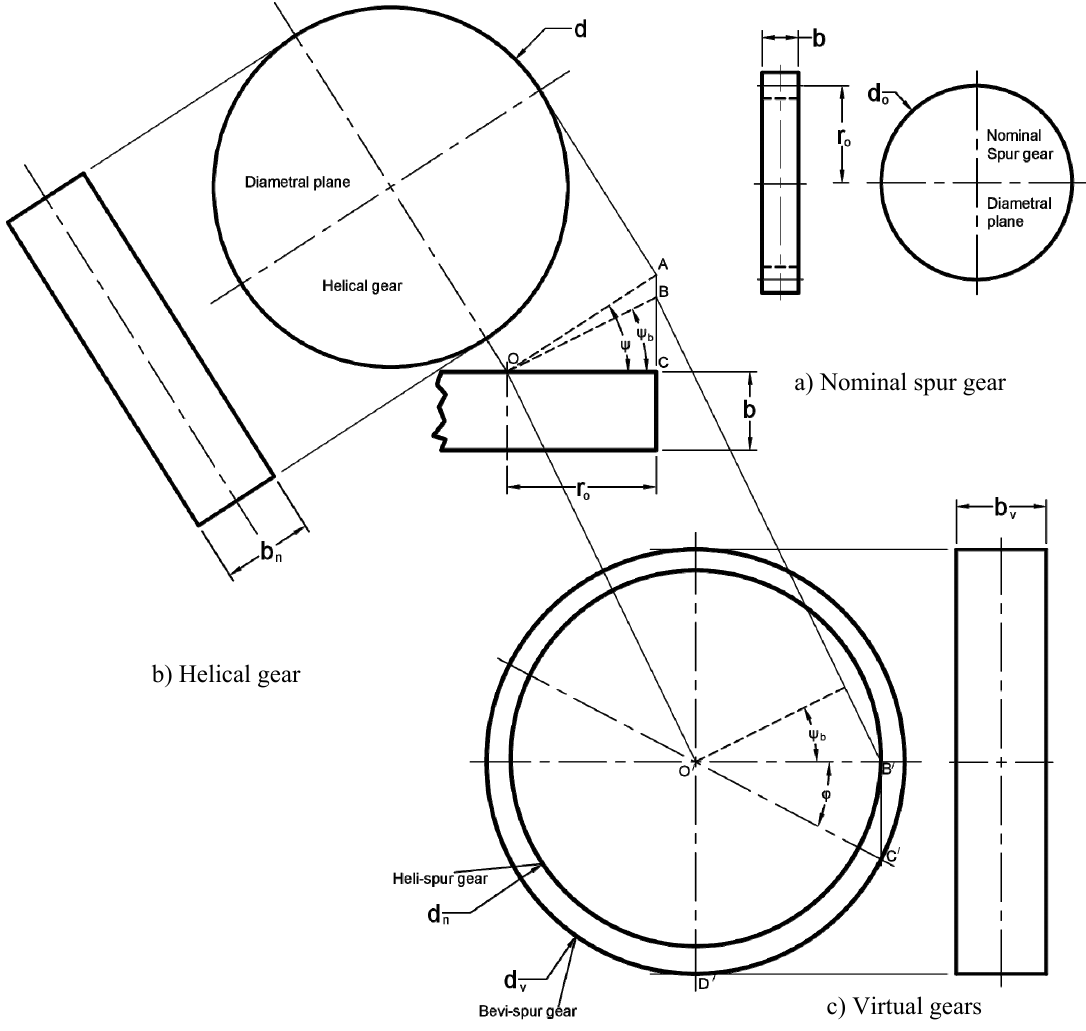
Figure 2: Graphical development of the pitch circle diameters of helical bevel